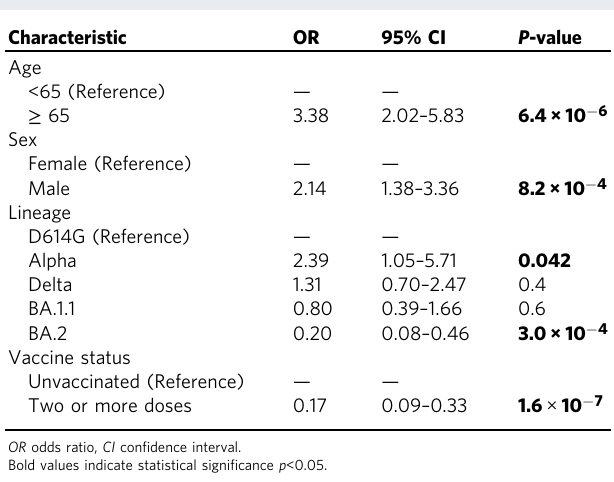
Table 1 Multivariant logistic regression for